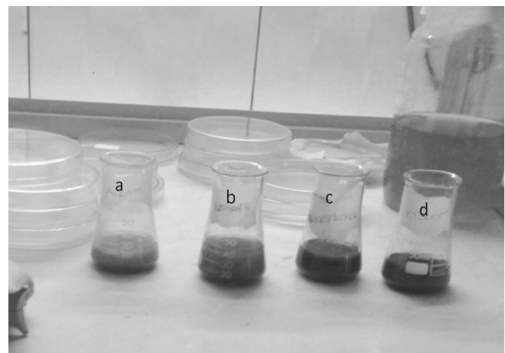
Figure 3: Botanical aqueous extracts: (a) Aframomum melegueta , (b) Cymbopogon citratus , (c) Piper nigrum , and (d) Xylopia aethiopica